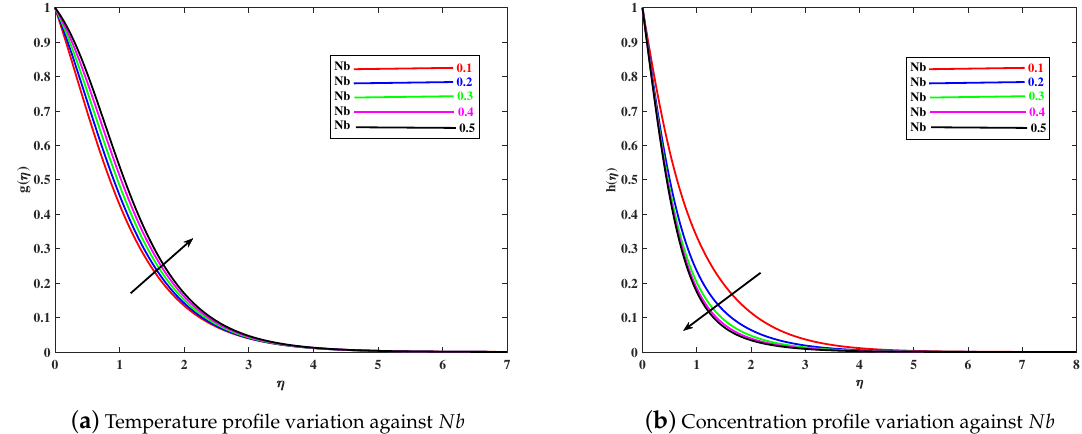
Figure 7. Effect of Nb to influence the thermal and concentration